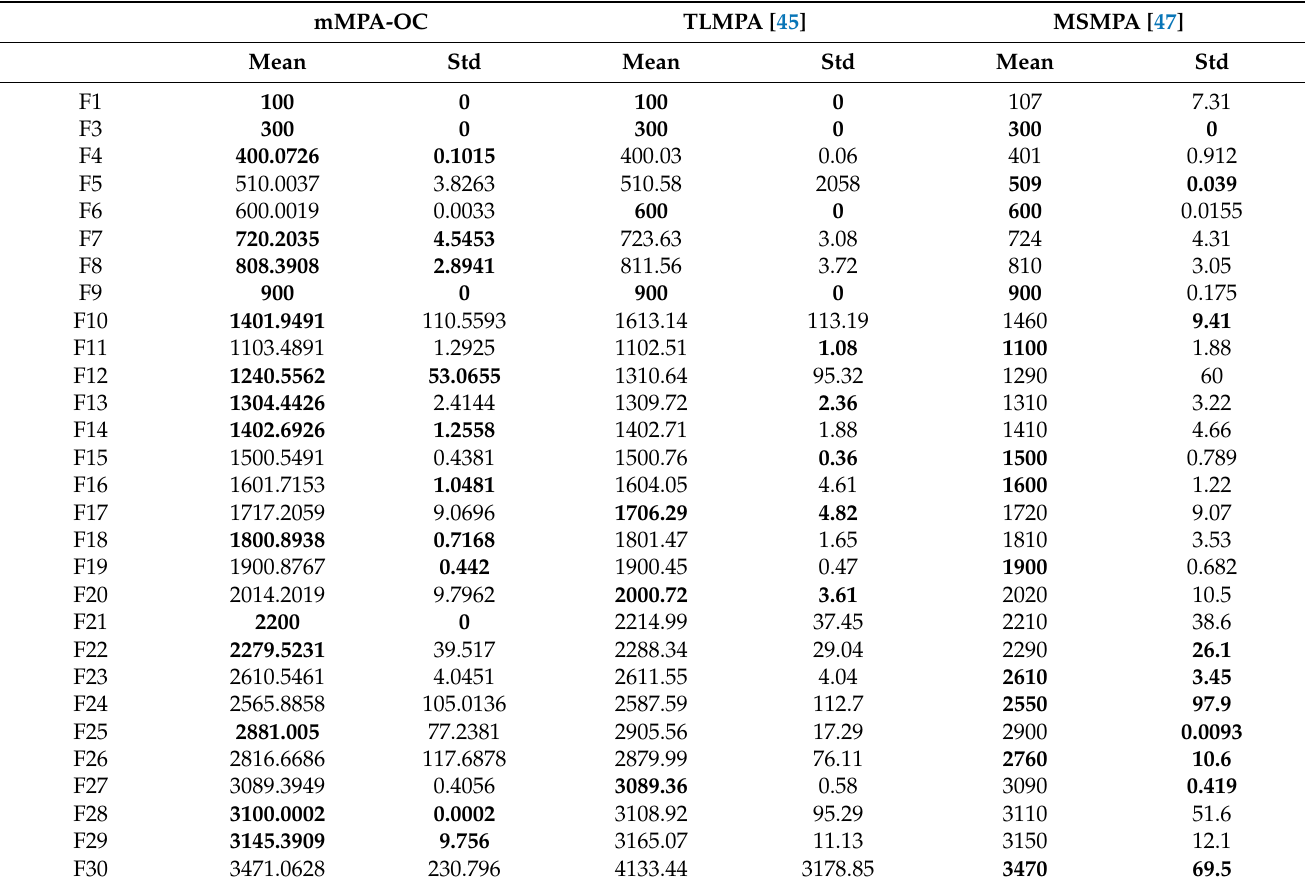
Table 9. Comparison of mMPA-OC with other improved algorithms in CEC-2017 (10